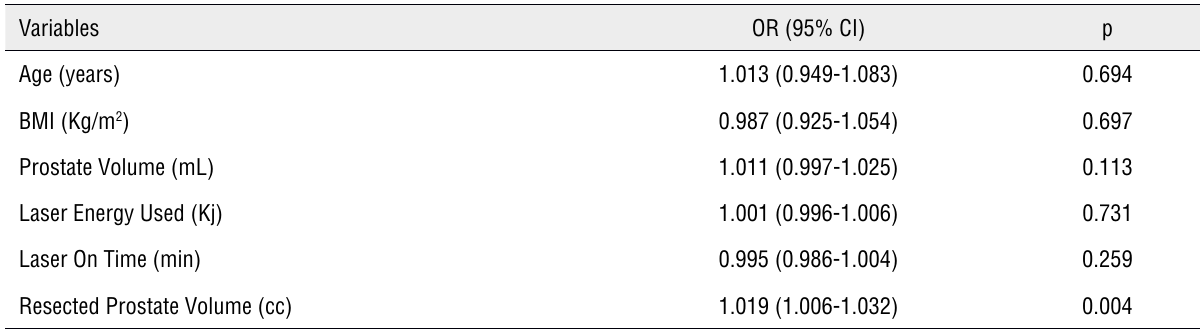
Supplementary Table 1.2 - Results from multivariable logistic regression analysis assessing for risk factors for tSUI in HoLEP patients.